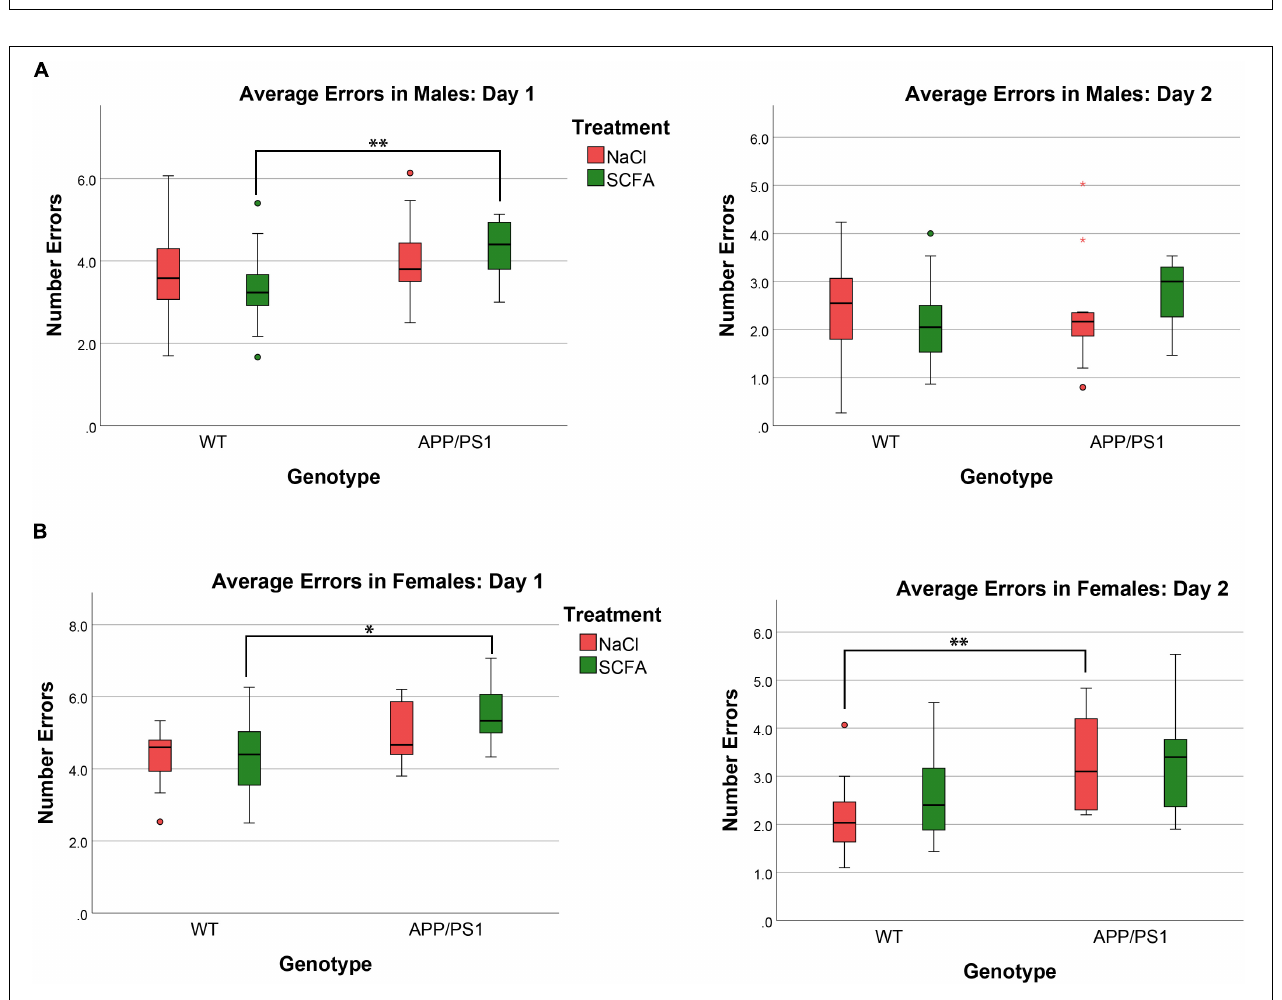
FIGURE 6 | Female but not male mice show cognitive deficits that are unaffected by short chain fatty acids (SCFA) treatment. The average number of errors on day one and day two are shown. On day one, significant differences were observed for both male and female mice between SCFA treated WT vs. APP/PS1 mice (A,B) . On day two, significant differences were observed only for female saline-treated WT vs. APP/PS1 mice (B) . Statistical significance was determined by using a general linear model ( ∗ = p < 0.05, ∗∗ = p < 0.01).